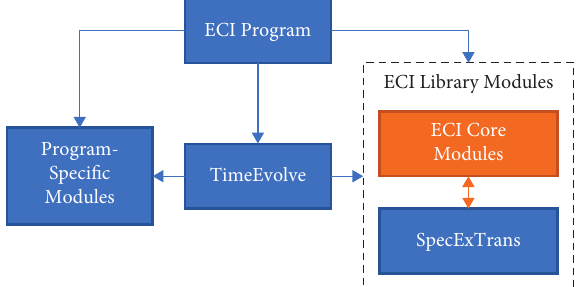
Figure 2: High-level structure of ECI program. From the entry point, the program must call ECI library subroutines to initialize ECI coupling, including scheduling data transfers. The program must then call the TimeEvolve subroutine, which is responsible for syn- chronization and all program-specific computations.